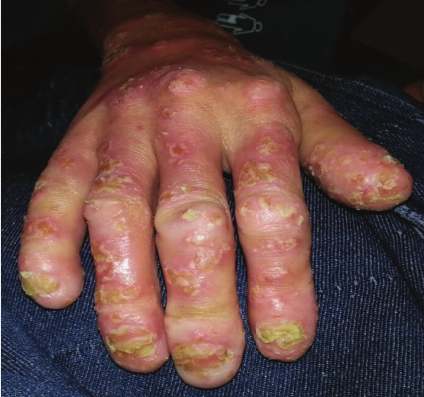
Figure 2: Nail dystrophies and finger joint deformities associated with psoriasis.